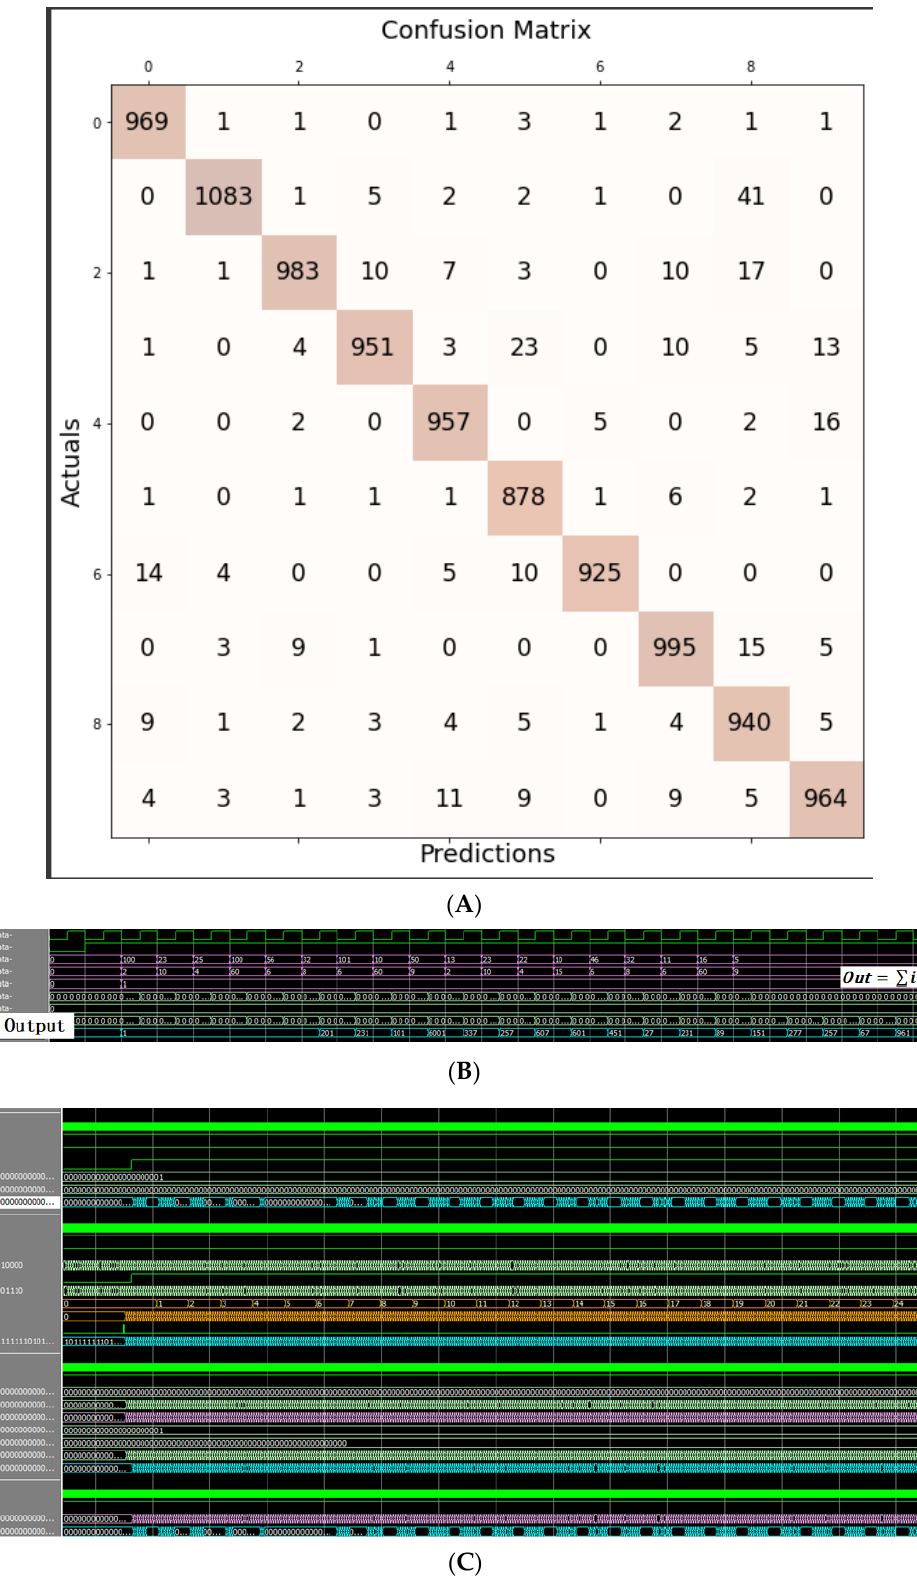
Figure 12. A customized GUI for testing.